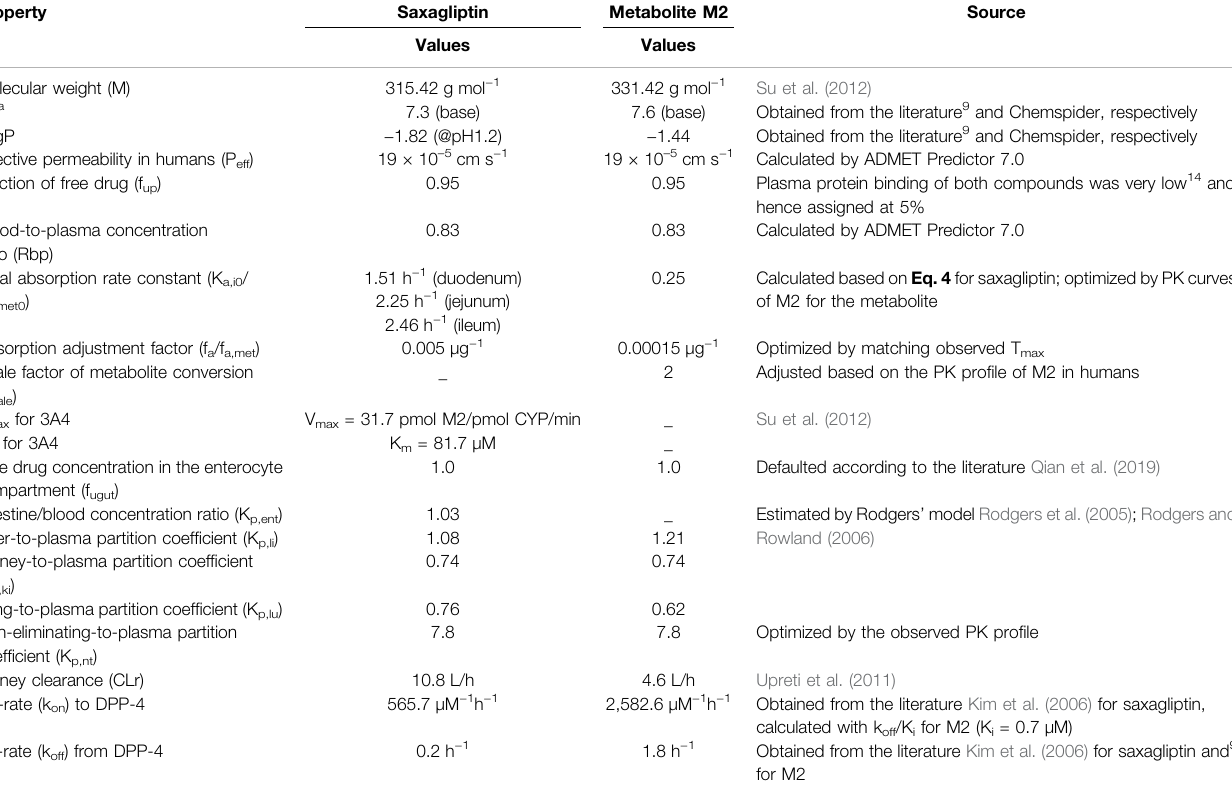
TABLE 1 | Summary of input parameters for saxagliptin and metabolite M2 in the PBPK-DO model.